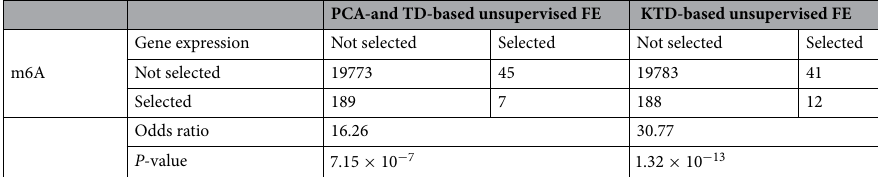
Table 9. Confusion matrices of selected genes between gene expression and m6A profiles. PCA-and TD-based unsupervised FE were separately applied to gene expression and m6A profiles, or KTD-based unsupervised FE was applied to the integration of gene expression and m6A